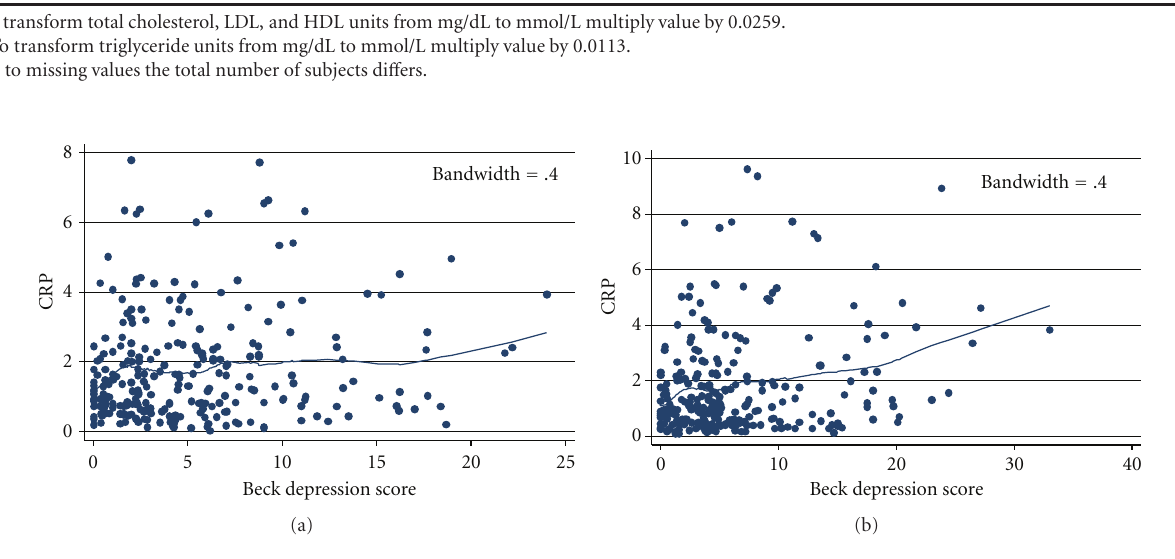
Figure 1: Association between Beck Depression Inventory score and high sensitivity C-reactive protein in men (a) and in women (b), SEASONS Study, Worcester MA,